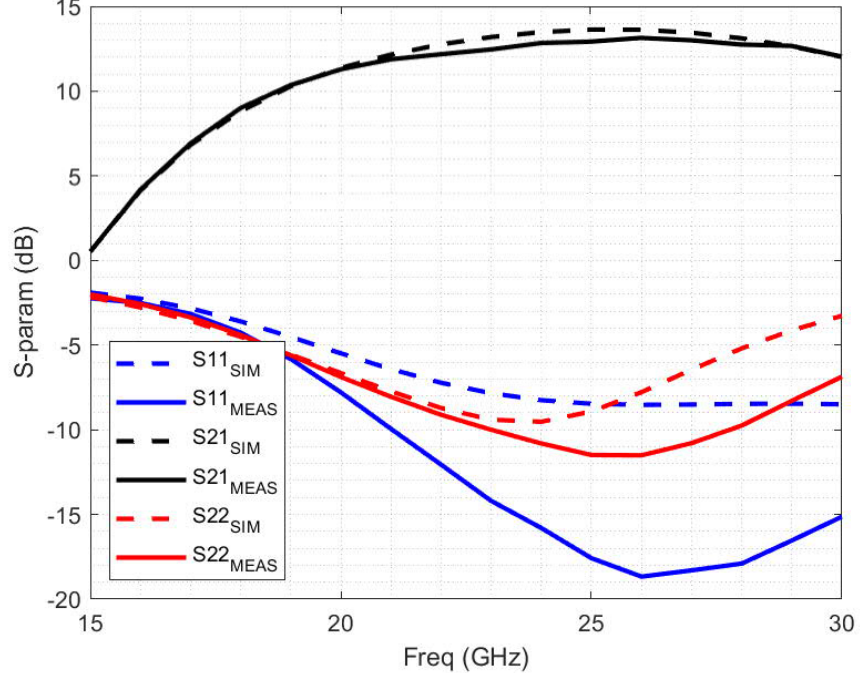
Figure 7. Comparison of the measured and simulated S-parameters of the stacked PA with maximum bias setting (Idq =